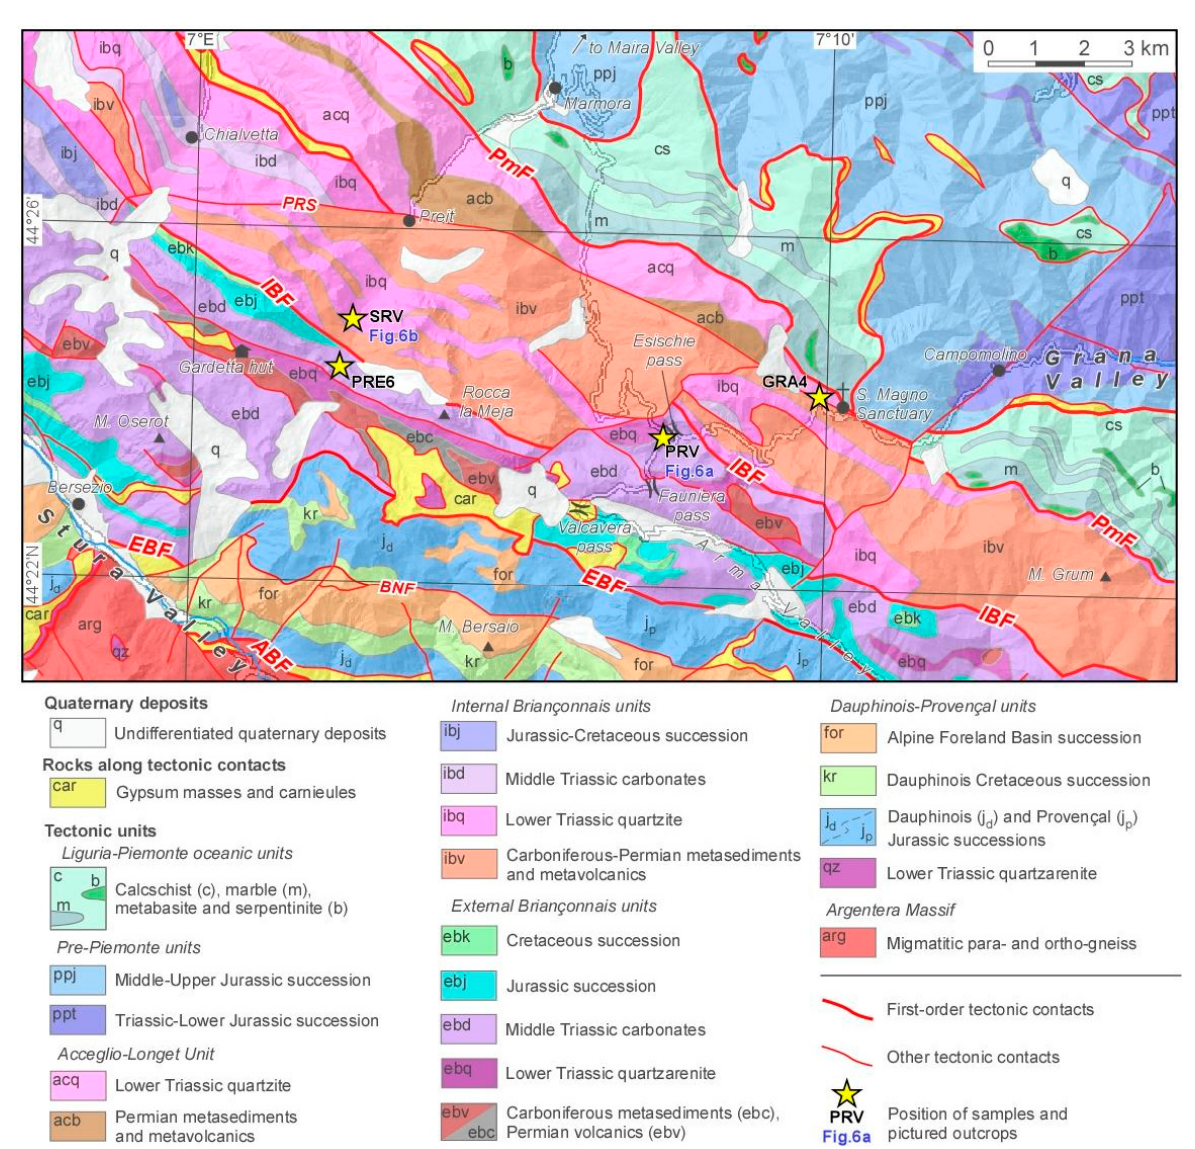
Figure 5. Geological map of the Gardetta highland area (modified from [19]), showing the sampling points of samples PRE6, PRV, and SRV and the position of outcrops pictured in Figure 6a,b. ABF: Argentera boundary fault system; BNF: Bersaio-Nebius Fault; EBF: External Briançonnais Front; IBF: Internal Briançonnais Front; PmF: Liguria-Piemonte units Front; PRS: Preit fault (“Preit Scar”).